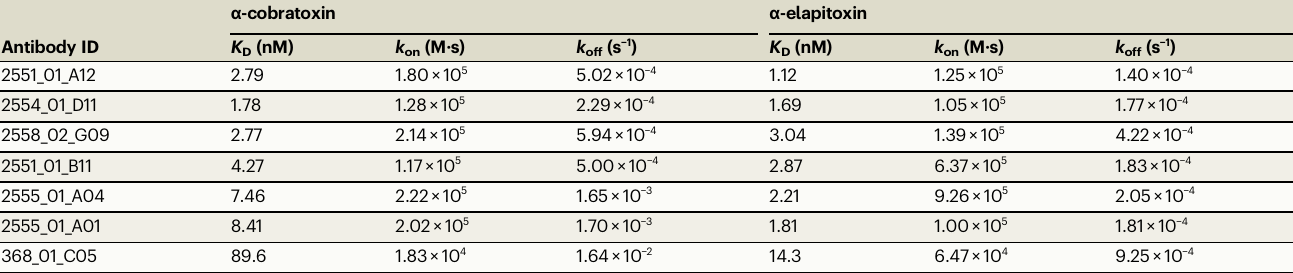
Table 2 | Af fi nity measurements between antibodies and toxins using Surface Plasmon Resonance (SPR) α -cobratoxin α